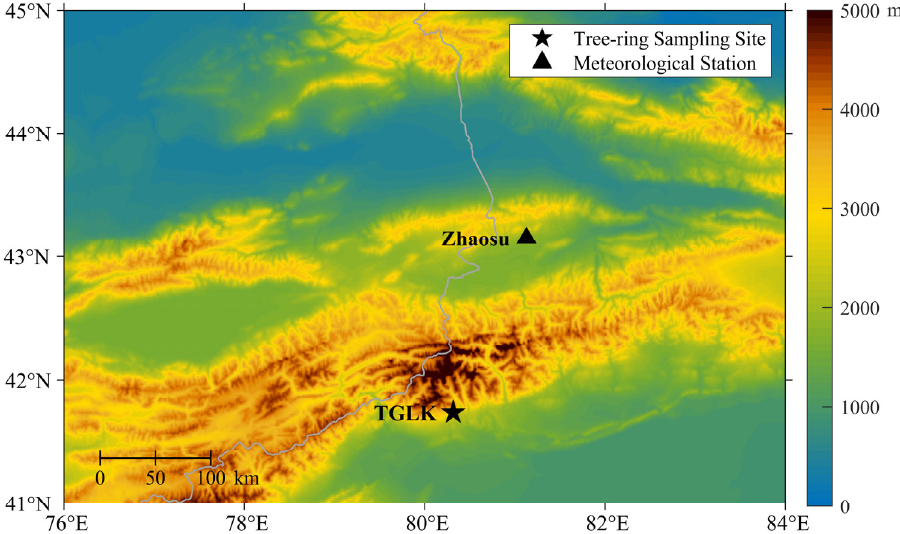
Figure 1. Map showing the location of the sampling site (Tagelake, TGLK) and the nearby Zhaosu meteorological station.